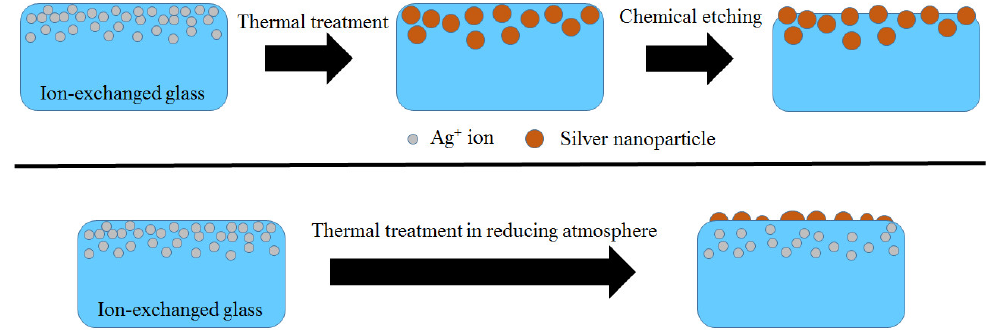
Figure 1. Schemes of two processes of formation of SNIF at the surface of Na + –Ag + ion-exchanged glass.